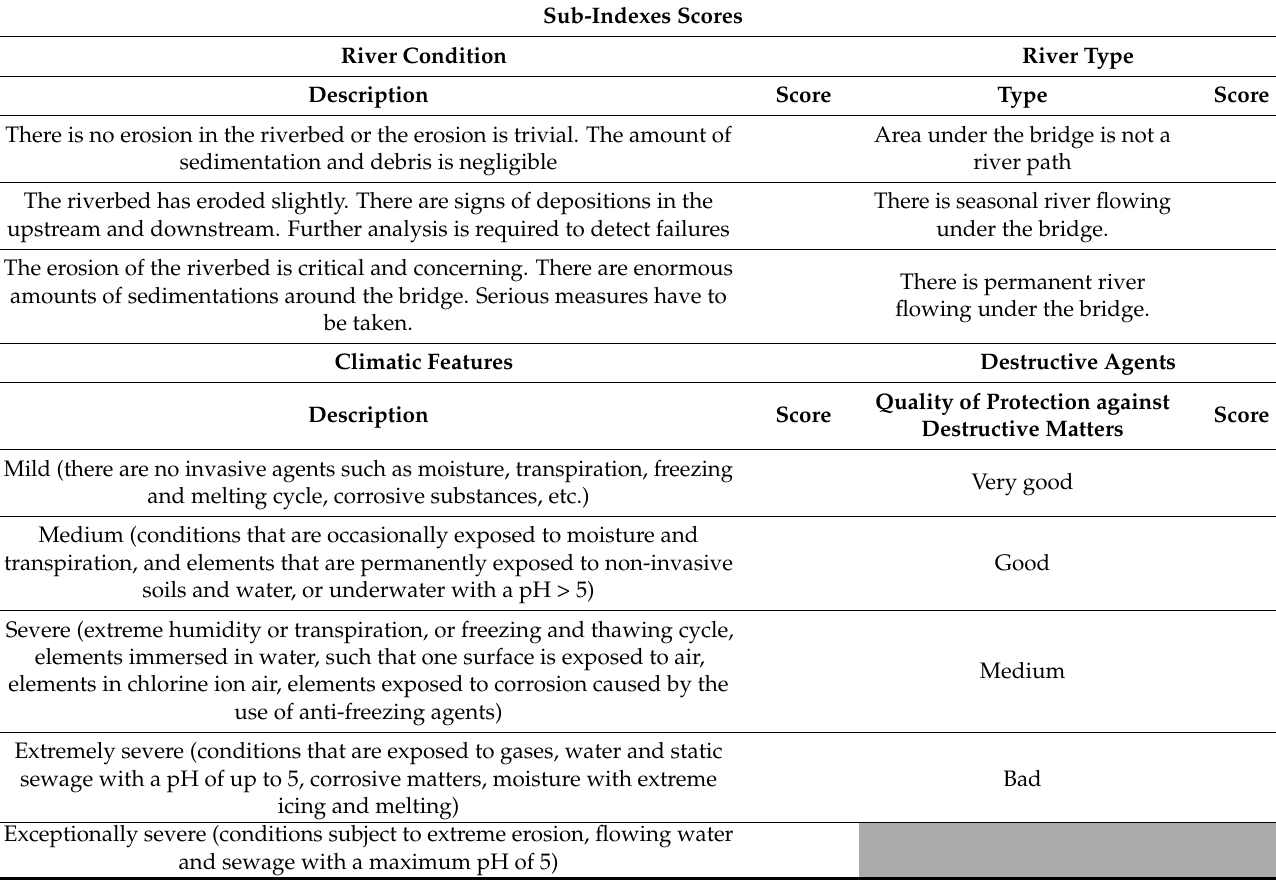
Table A4. Scores of sub-indexes in hydrology and climate index.